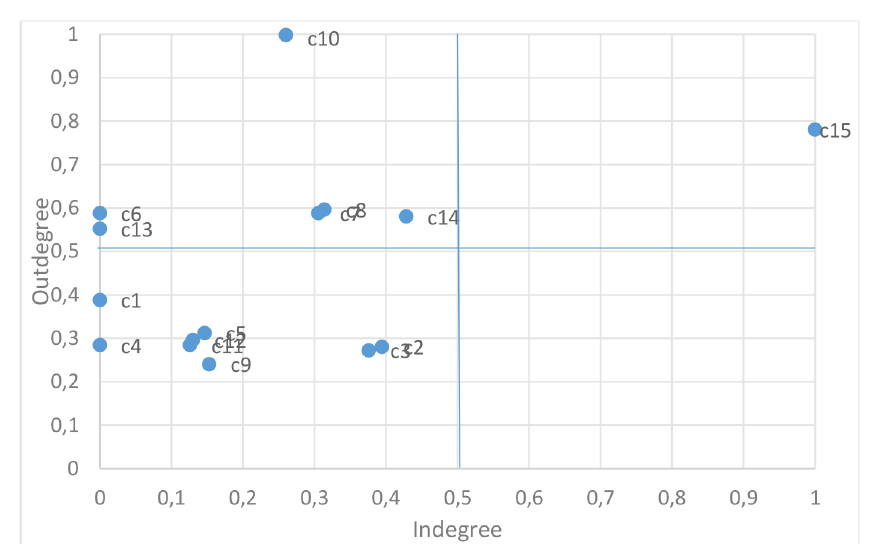
Table 8. Outdegree, indegree and centrality of each node